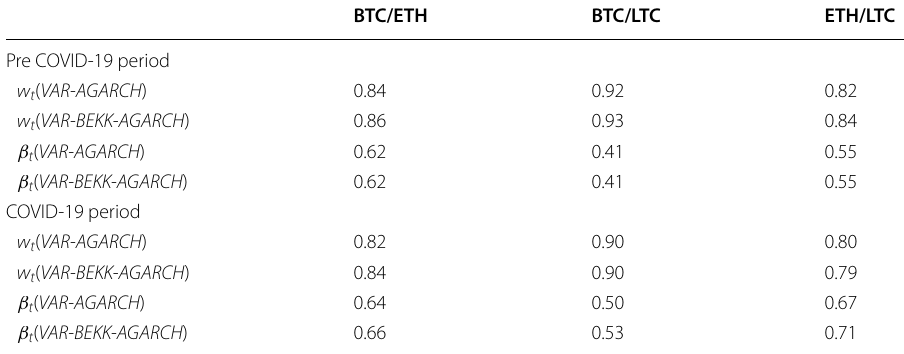
w t and β t refer to the optimal weights and hedge ratios,